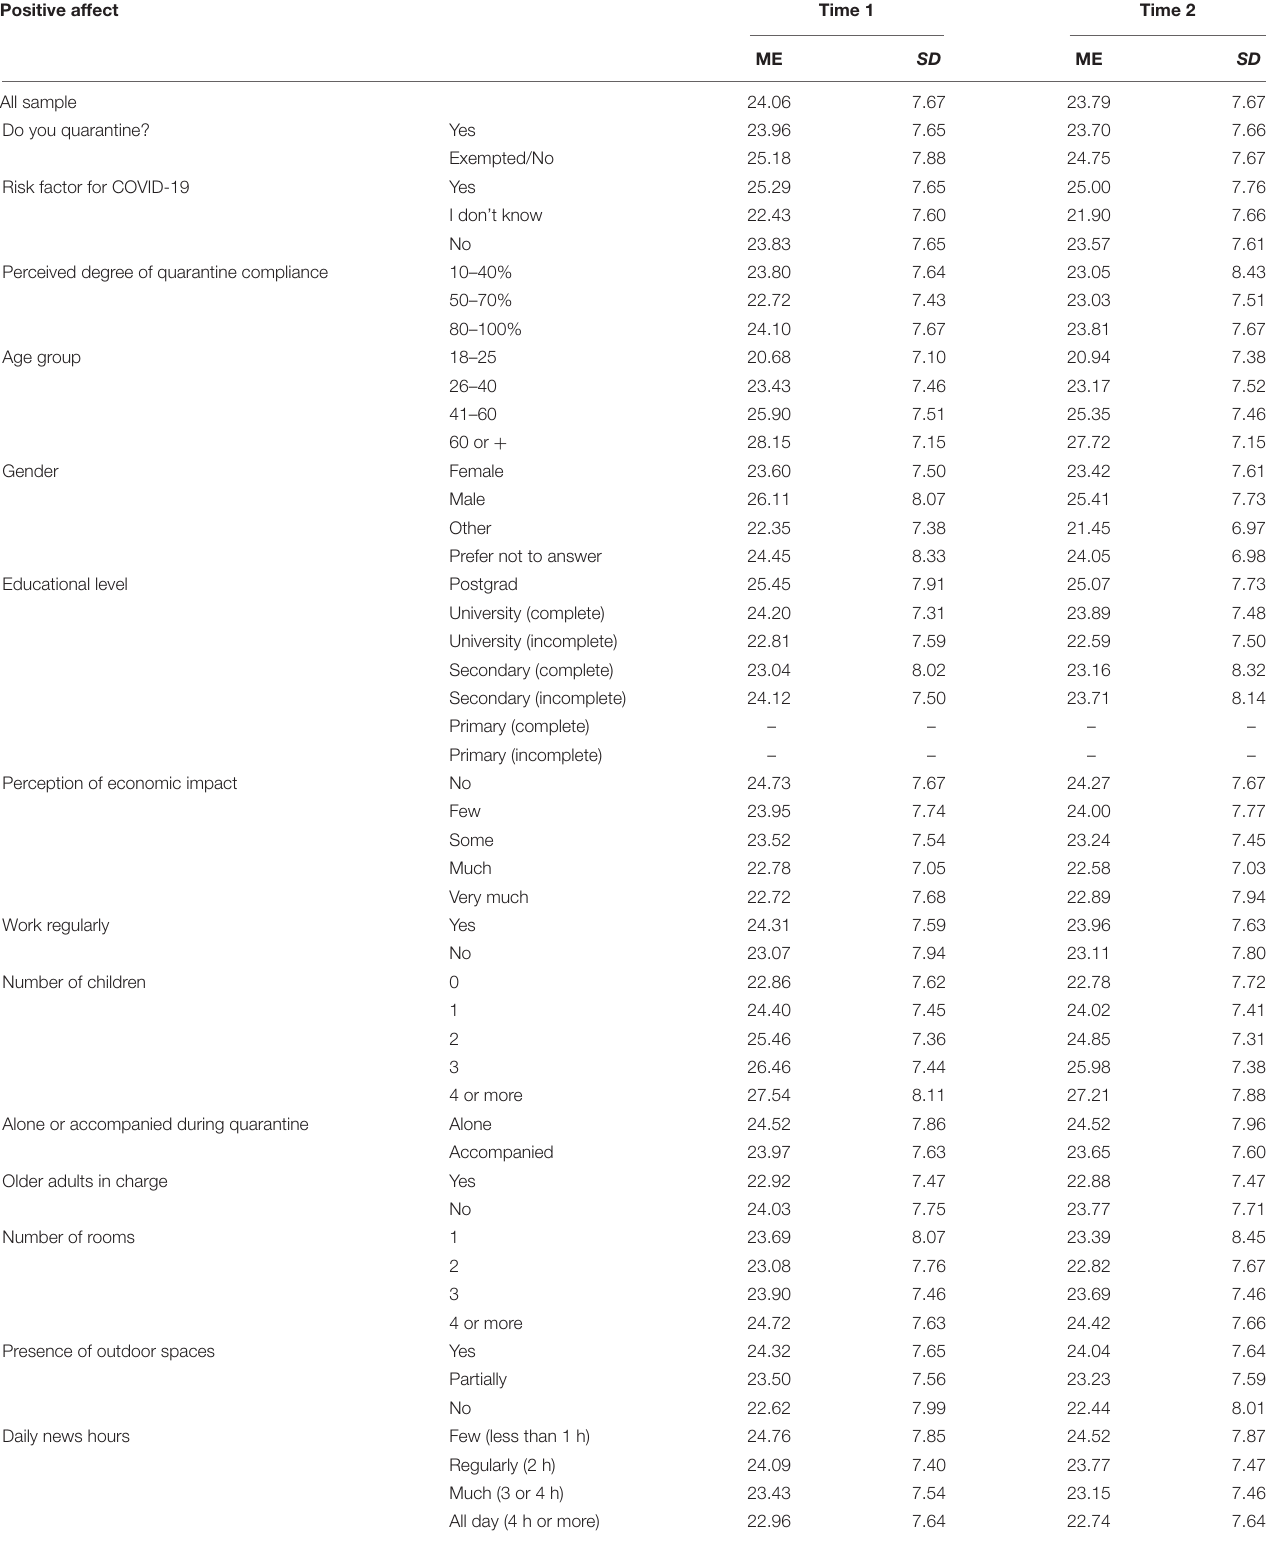
TABLE 8 | Descriptive statistics for positive affect in Time 1 and Time